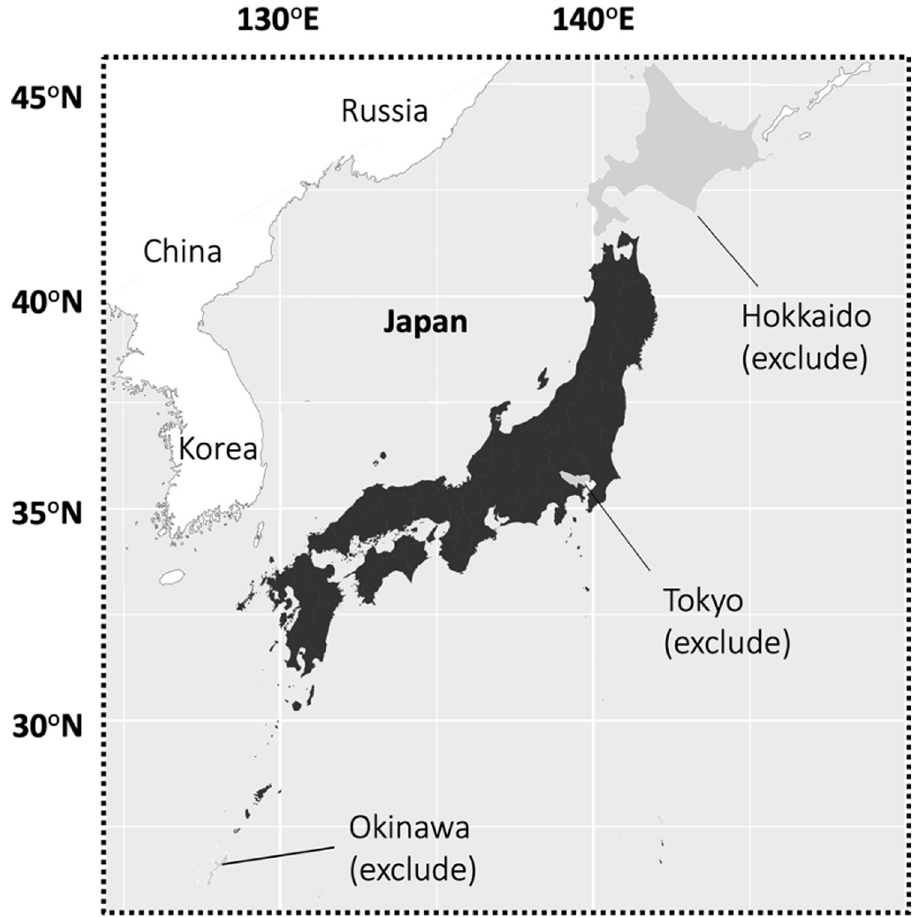
Fig 1. Map of Japan indicating study site regions. Japan is indicated in black and gray: Black shows where the data for the analysis were gathered; the gray areas show where the data were excluded, that is, Hokkaido, Tokyo, and Okinawa. This map was created based on Natural Earth data (http://www.naturalearthdata.com/).